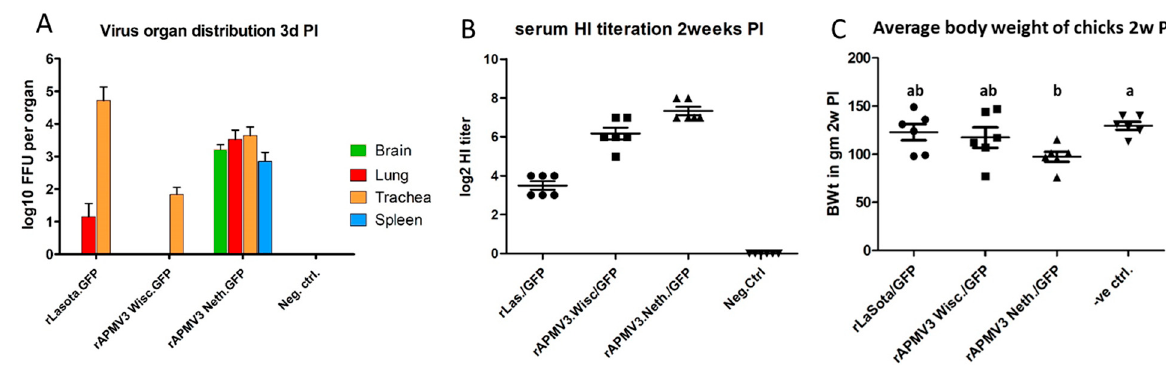
Figure 4. Replication of rLaSota\GFP, rAPMV-3 Wisc.\GFP and rAPMV-3 Neth.\GFP in SPF chickens. ( A ) Three birds of each immunized group were sacrificed 3 days after infection and different organs (brain, lung, trachea, and spleen) from each bird were titrated for the used APMV vector in DF-1 cells. The plotted virus titers in different organs are expressed as the mean FFU per organ. ( B ) Serum samples of chickens immunized by rLaSota\GFP, rAPMV-3 Wisc.\GFP and rAPMV-3 Neth.\GFP were analyzed two weeks after infection for HI activity against 4 HAU of the vaccinating virus. Results represent the mean log 2 HI titers of six birds from each immunized group. (the error bar represents standard error of the mean (SEM)). ( C ) Average body weight of chicken groups (gm) two weeks post vaccination.